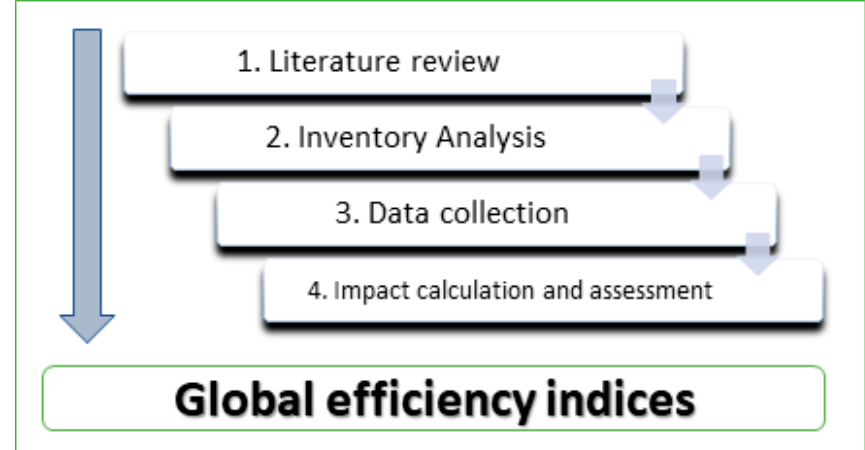
Figure 1. Work methodology.